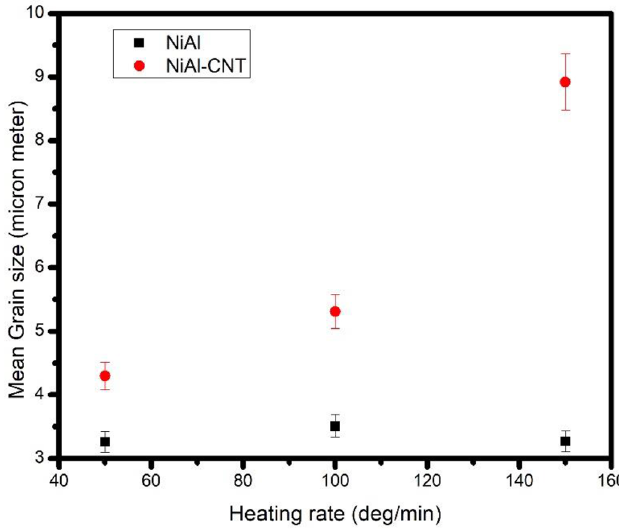
Fig. 6. The mean grain size plots of the consolidated specimens.